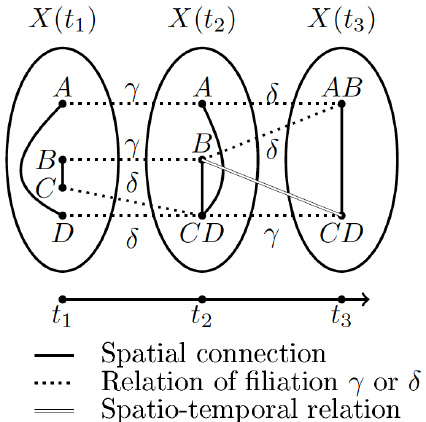
Figure 2. A spatio-temporal graph from [8]. A , B , C , D and CD are four spatial entities present at the first time t 1 . X ( t i ) represents the set of spatial entities present at time t i . Spatial relations are denoted with plain lines, filiations are shown with dotted lines with labels γ and δ to denote continuations and derivations and spatio-temporal relations are shown with a double line. C and D combine at time t 2 to a new entity CD which derives from them. CD continues at t 3 while A and B combine at t 3 to a new entity AB